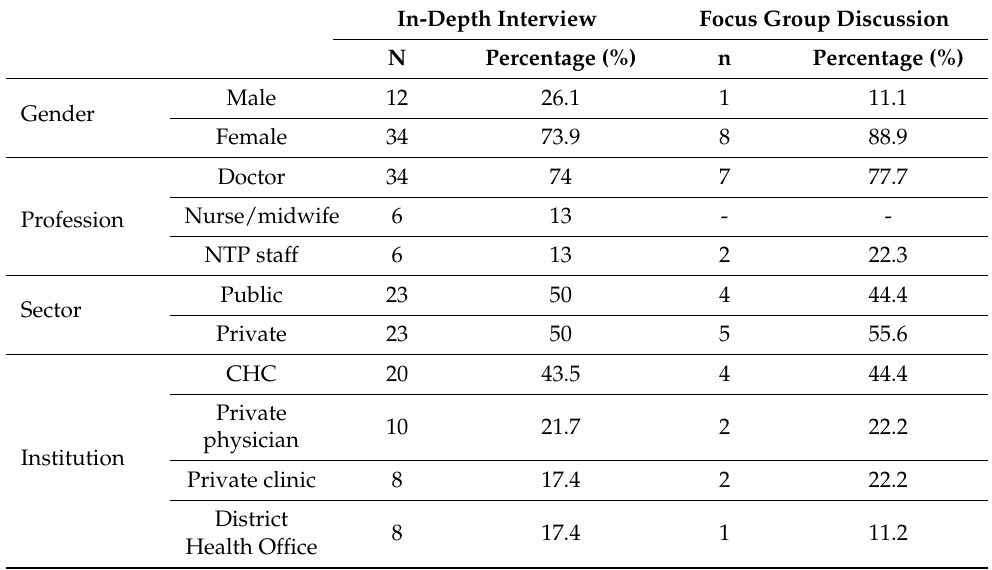
Table 1. Characteristic of